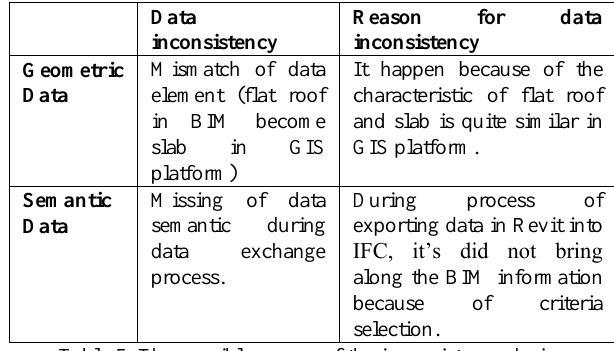
Table 5. The possible causes of the inconsistency during exporting